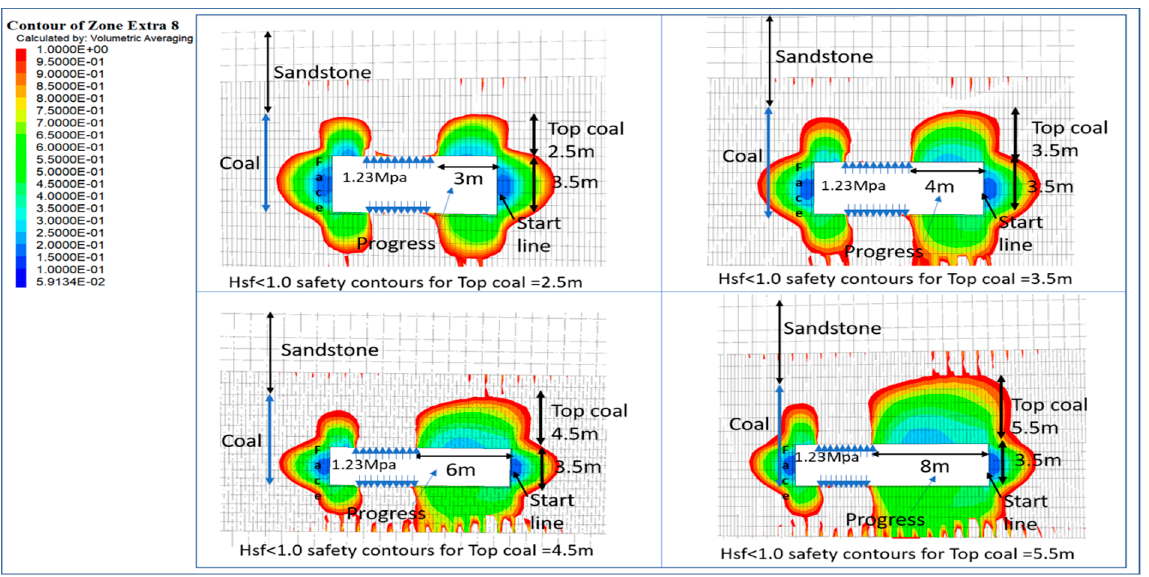
Figure 5. Modeling for different top coal thickness values. Scenario V: Modeling for different extraction height values: